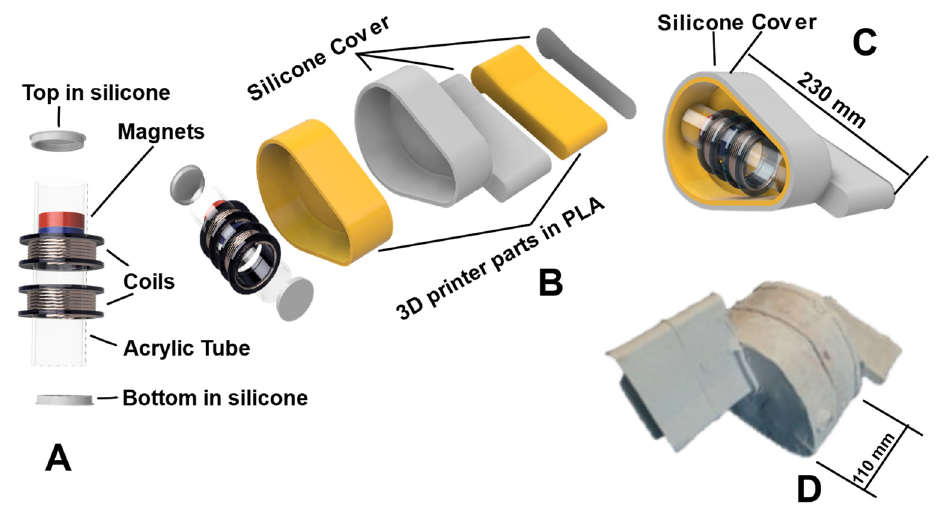
Figure 1. Energy harvesting device. ( A ) LEG, consisting of two copper coils, acrylic tube and silicone stops. ( B ) Body in cut to show the LEG and its components. ( C ) Body assembled in cut. ( D ) Silicone outer shell of